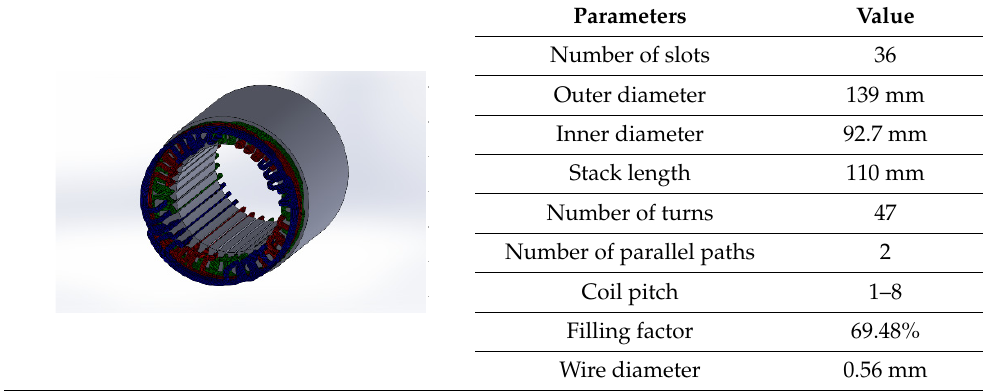
Table 1. Main motor stator design parameters. Table 1. M ain motor stator design